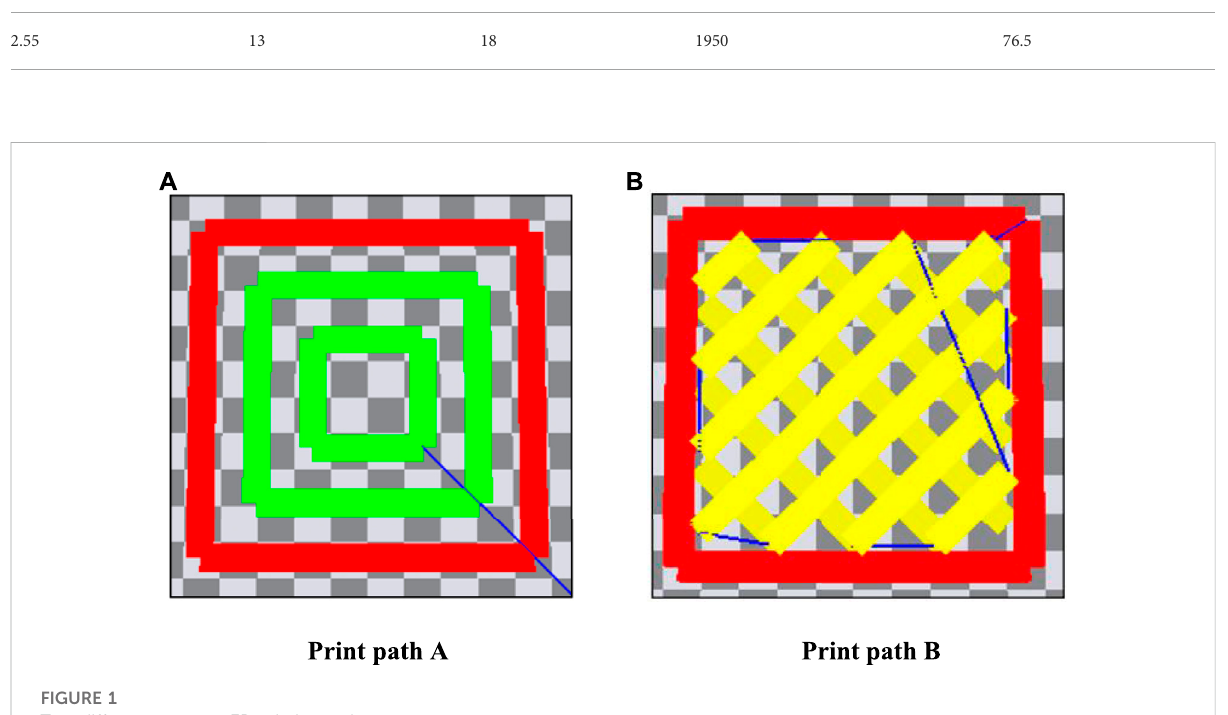
FIGURE 1 Two different concrete 3D printing